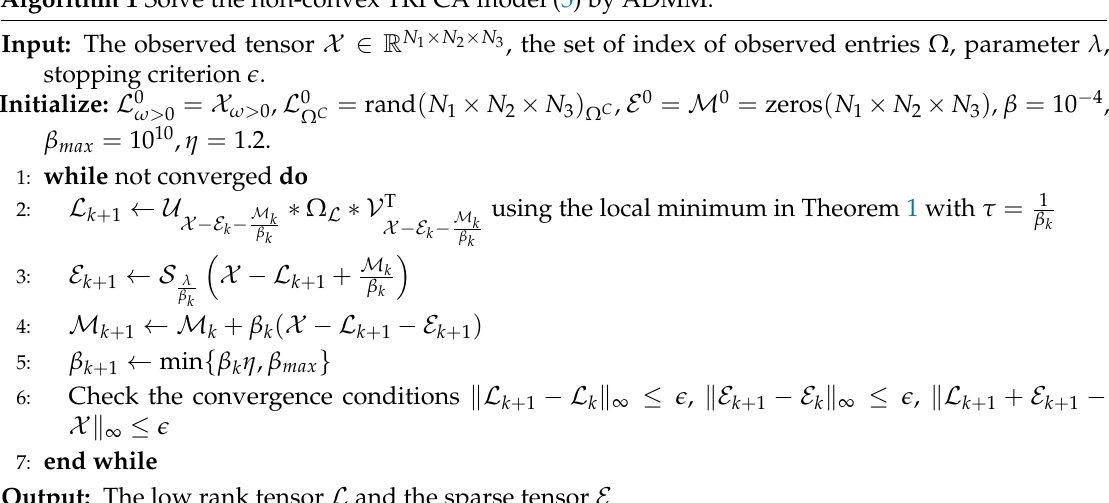
Algorithm 1 Solve the non-convex TRPCA model (5) by